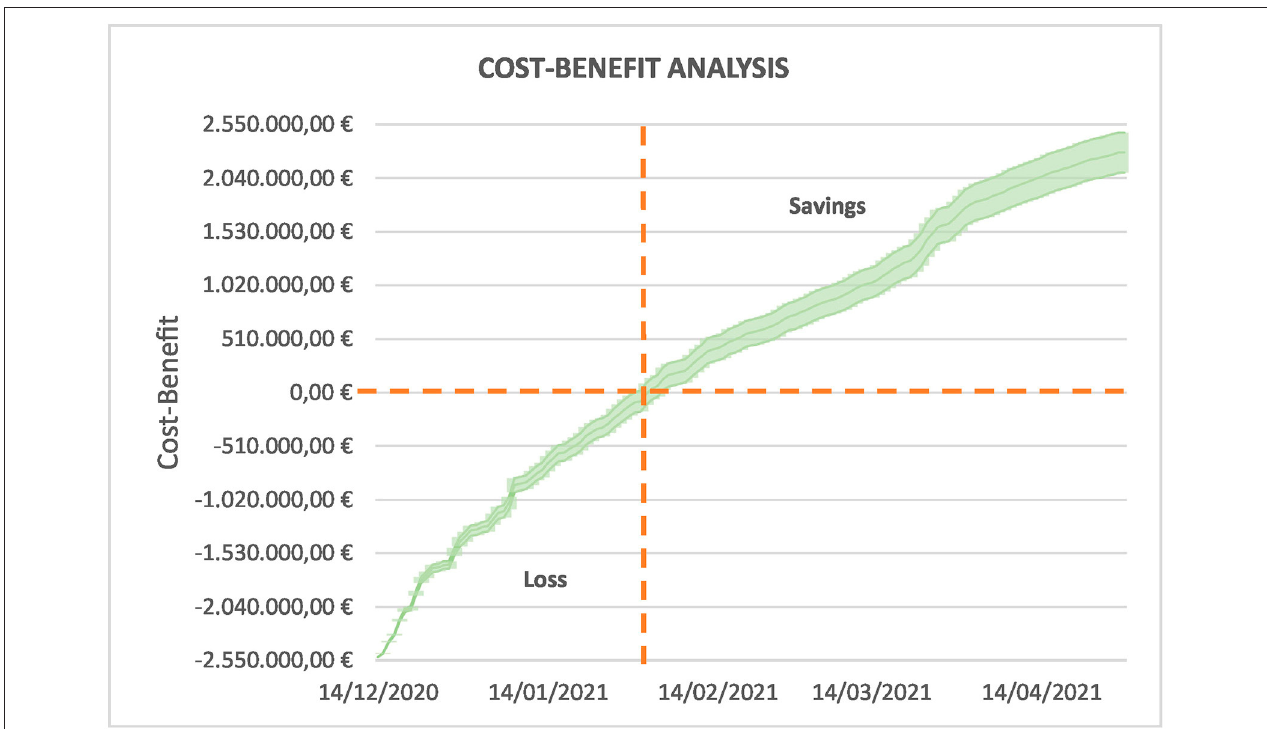
FIGURE 9 | Daily evolution of savings for the public budgets. The measure starts to be beneficial from the beginning of February and the savings exceed e 2.000.000 by the end of